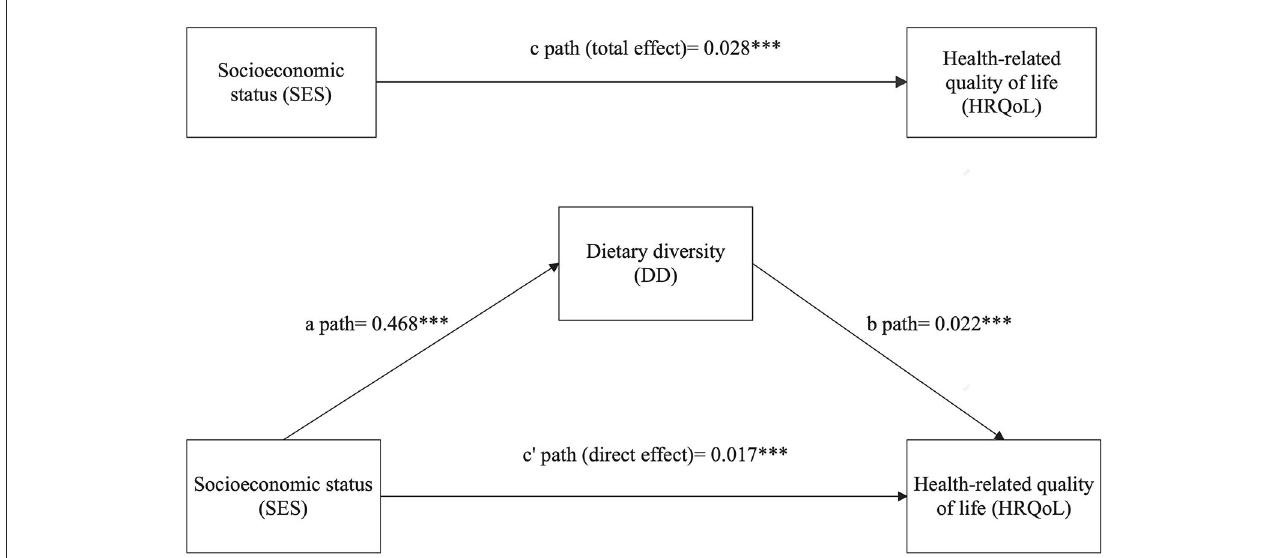
FIGURE1 The mediation model of the association between SES and HRQoL through dietary diversity, adjusted for age, gender, residential area, marital status, family size, physical activities, body mass index, and the number of chronic diseases. Path coefficients are shown. *** p < 0.001.